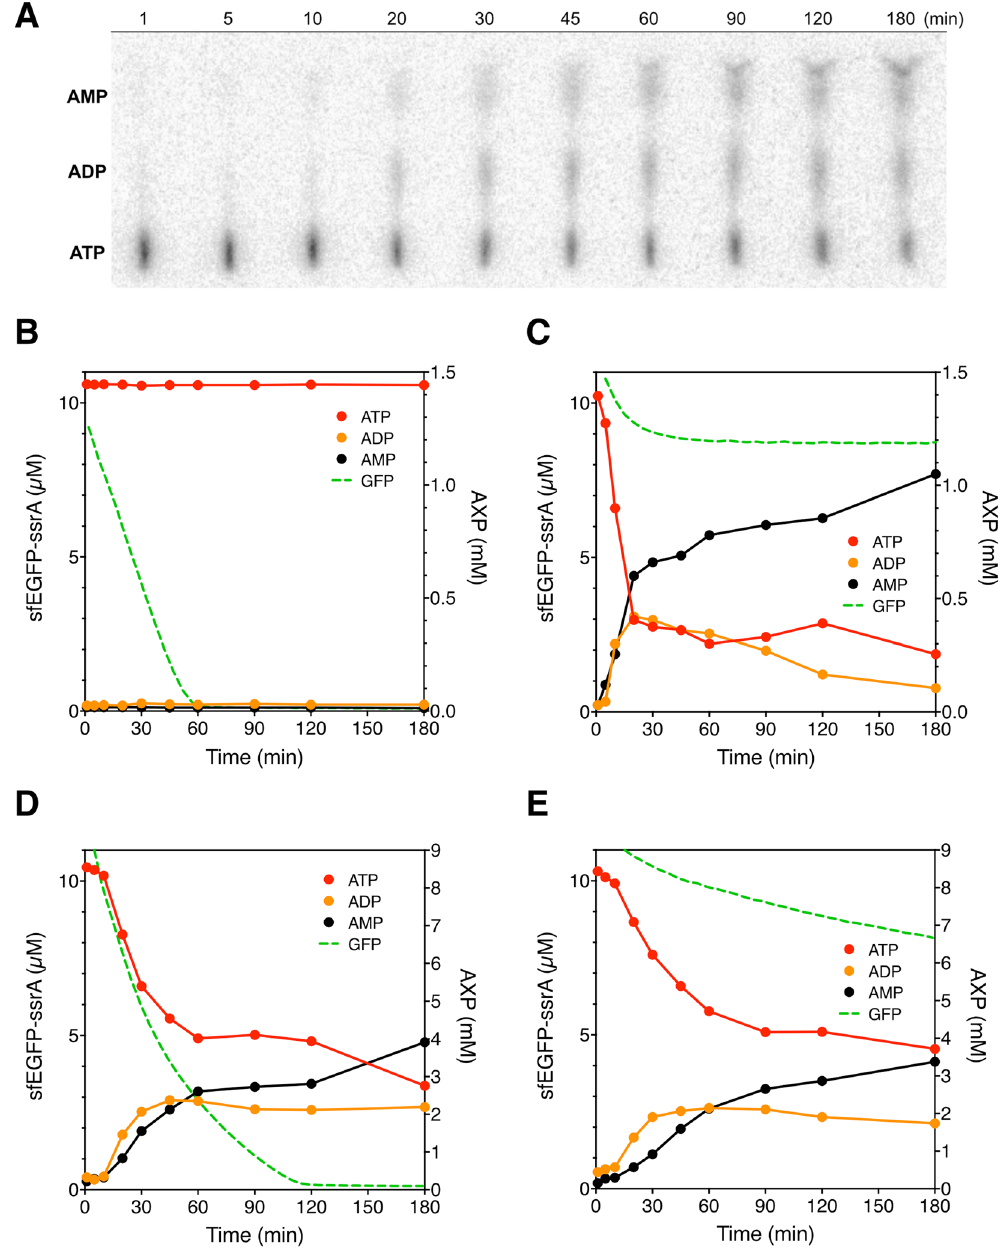
Figure 4. ATP consumption and protein degradation by ClpXP. ( A ) A representative phosphor image of ATP consumption assay by ClpXP in the TX-TL system with additional 8 mM ATP, 16 mM phosphoenolpyruvate, and 16 U/mL pyruvate kinase. Samples were collected and quenched at 1, 5, 10, 20, 30, 45, 60, 90, 120, and 180 minutes after the reaction started. ATP, ADP, and AMP were separated on a PEI-cellulose TLC plate and quantified with a phosphor imager. The dark spots correspond to radioactive ATP, ADP, and AMP, respectively, from bottom to top. Spots were quantified and normalized by each lane and the ratio of each adenosine phosphate species were plotted. ( B – E ) are graphs showing protein degradation and ATP consumption. All reactions were performed with 300 nM ClpXP (except in ( E )) and 10 µ M sfEGFP-ssrA in different conditions for 3 hours. ( B ) The reaction was performed in premix 1. ( C ) The reaction was performed in the TX-TL system with premix 1. ( D ) The reaction was performed in the TX-TL system with premix 4. ( E ) The reaction was performed without ClpXP in the TX-TL system with premix 4. Data are representative of at least three repeated